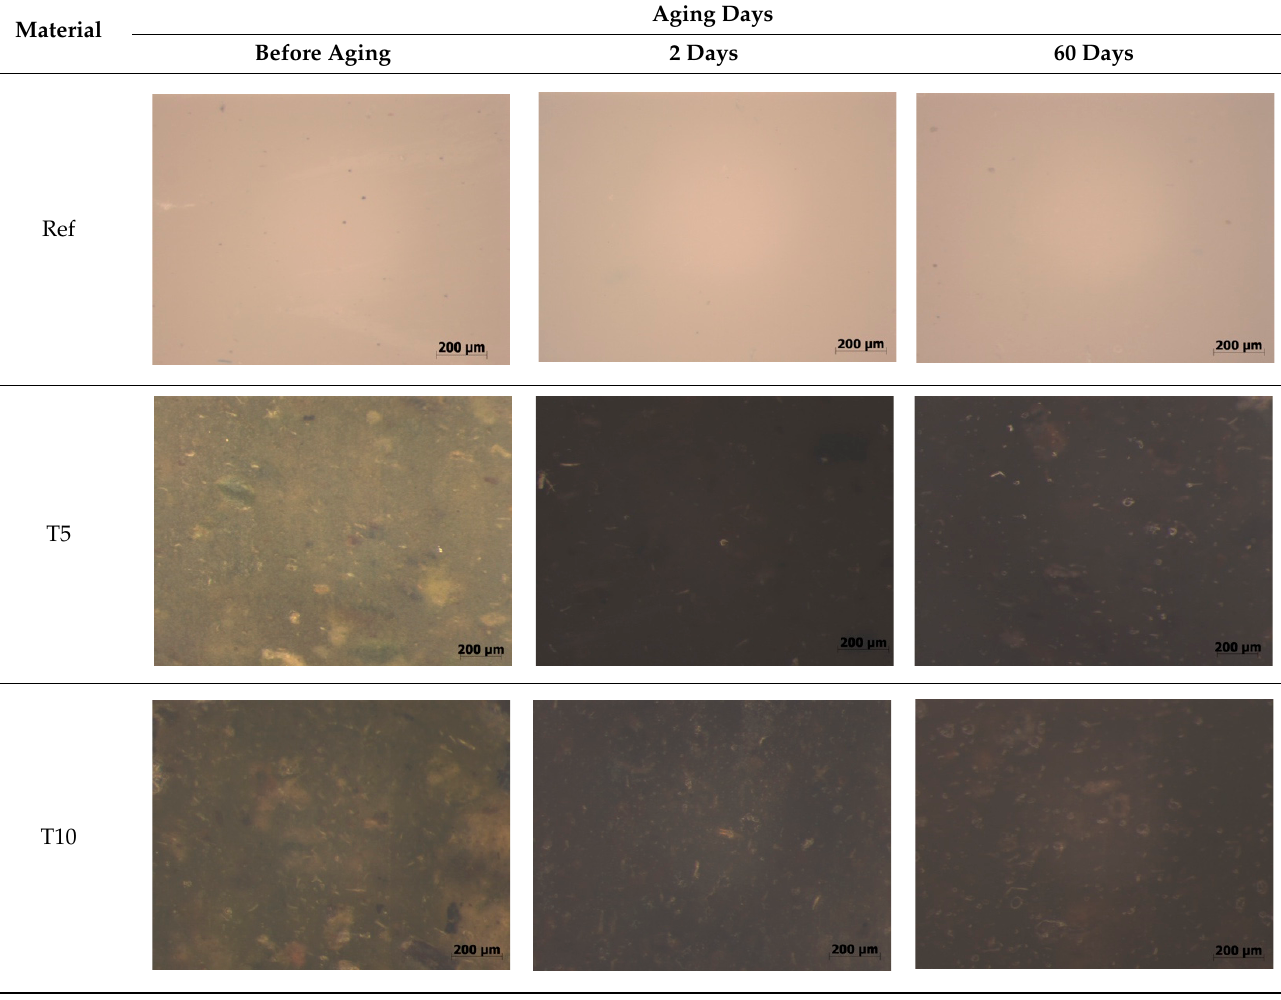
Table 4. Accelerated aging results.